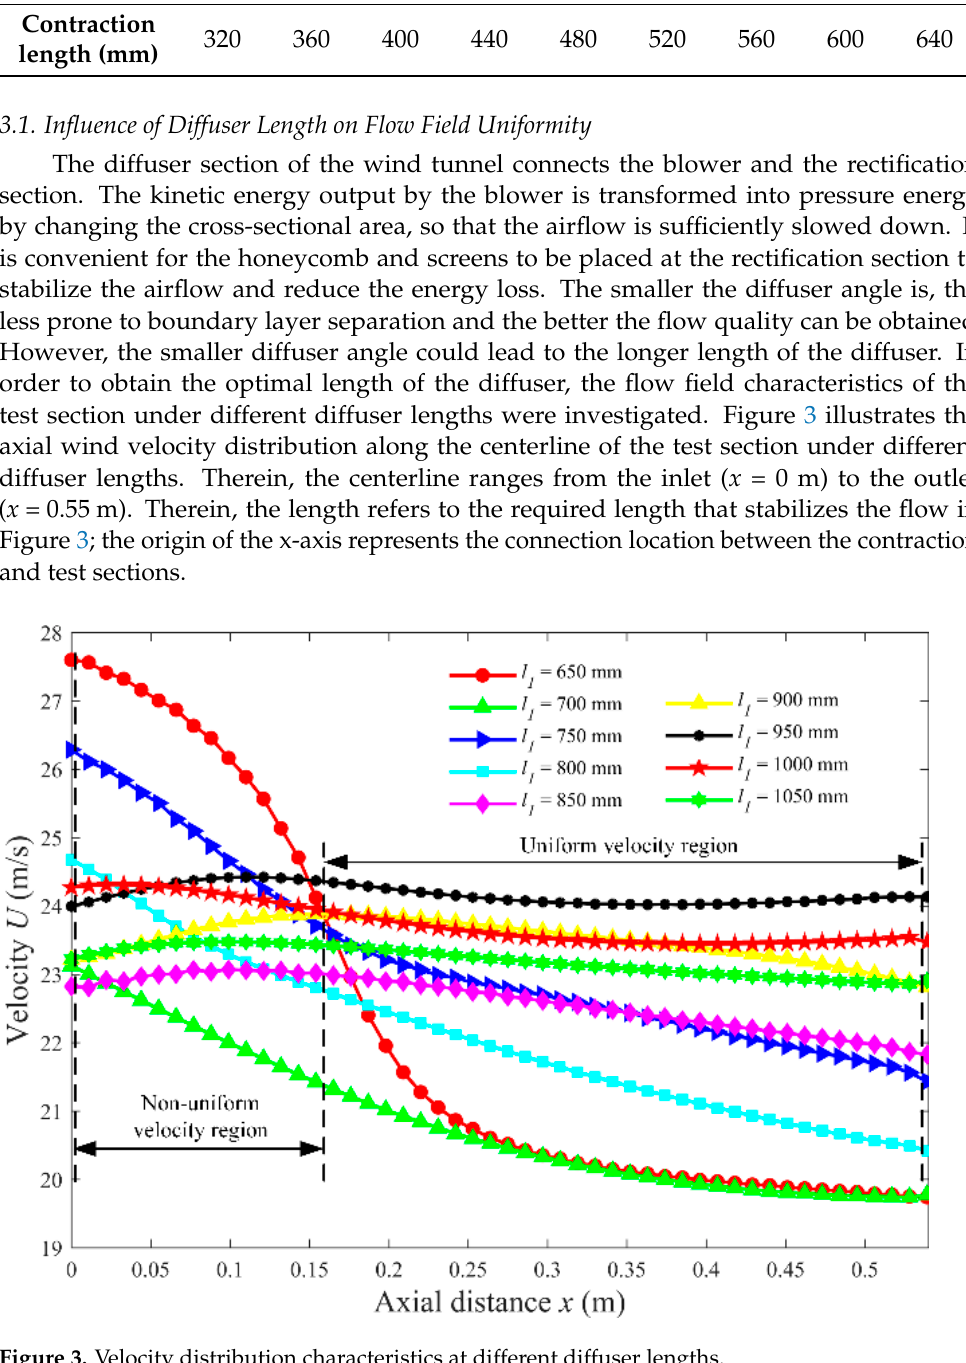
Table 1. Lengths of diffuser and contraction section.